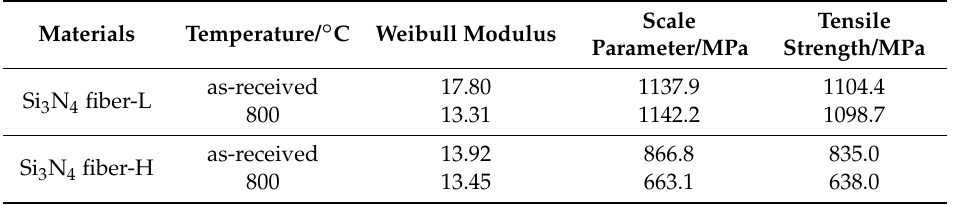
under vacuum. Table 3. Comparisons of Weibull statistics and tensile strength of two Si 3 N 4 fiber bundles annealed under